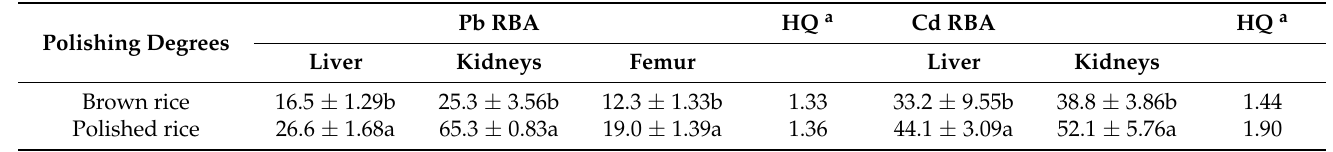
Table 2. Pb and Cd relative bioavailability (RBA) and bioavailability-corrected hazard quotient (HQ) in mouse organs by consuming brown rice or polished rice (%, Mean ± SD, n = 3).